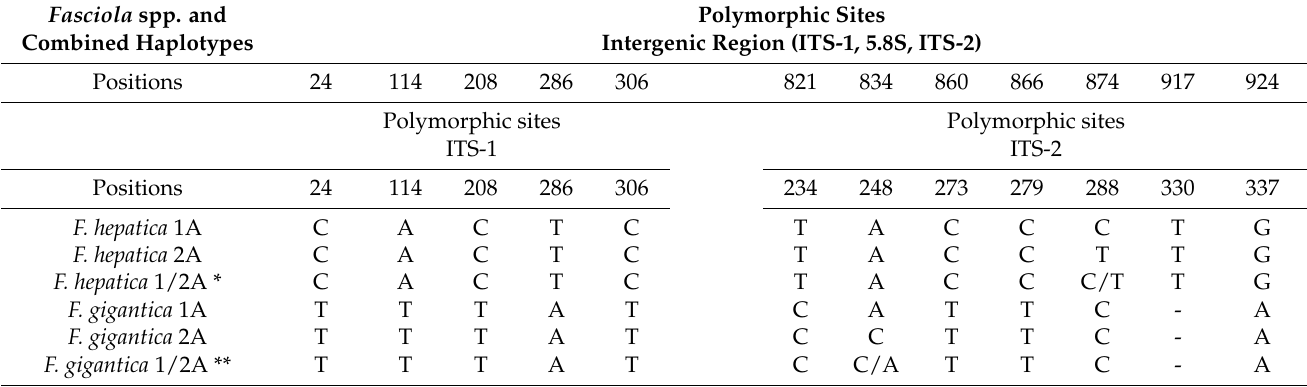
* = heterozygotic in position 874/288 not differentiating between F. hepatica and F. gigantica . ** = heterozygotic in position 834/248 not differentiating between F. hepatica and F. gigantica (also designed as H3A in Chougar et al. [26]. GenBank accession numbers for whole intergenic region: F. hepatica H1A = MG569980; F. hepatica H2A = MG569981; F. gigantica H1A =